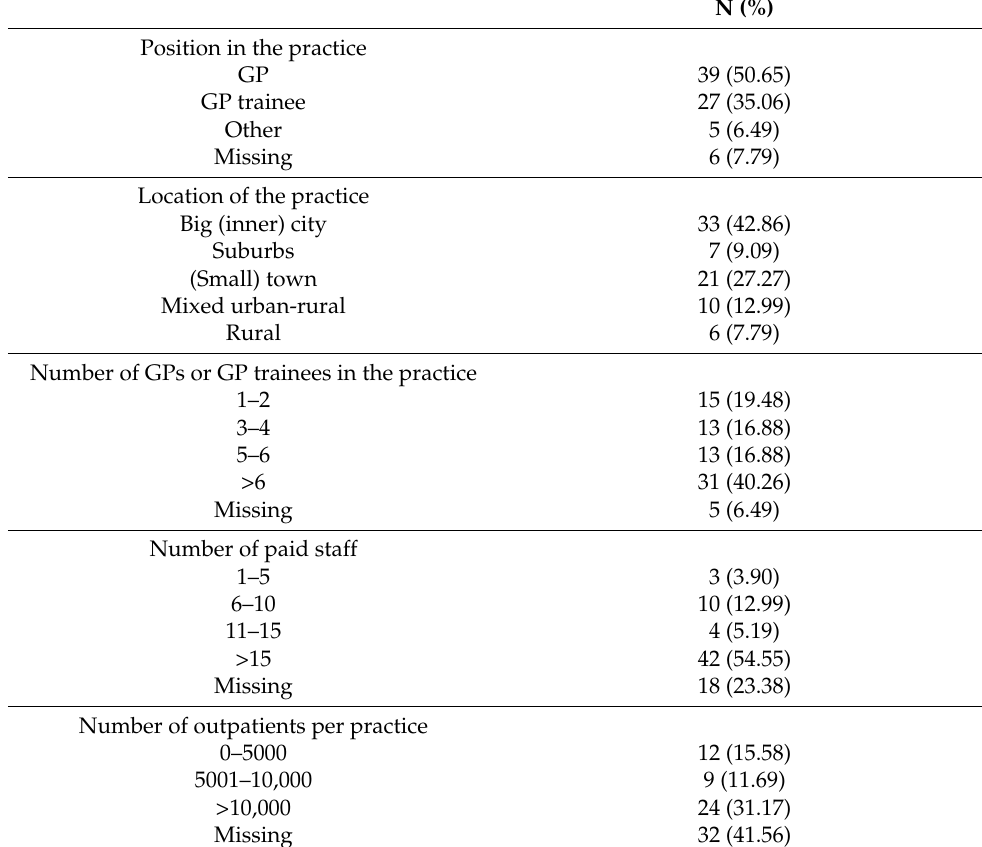
Table 1. Characteristics of Kosovar respondents of the PRICOV-19